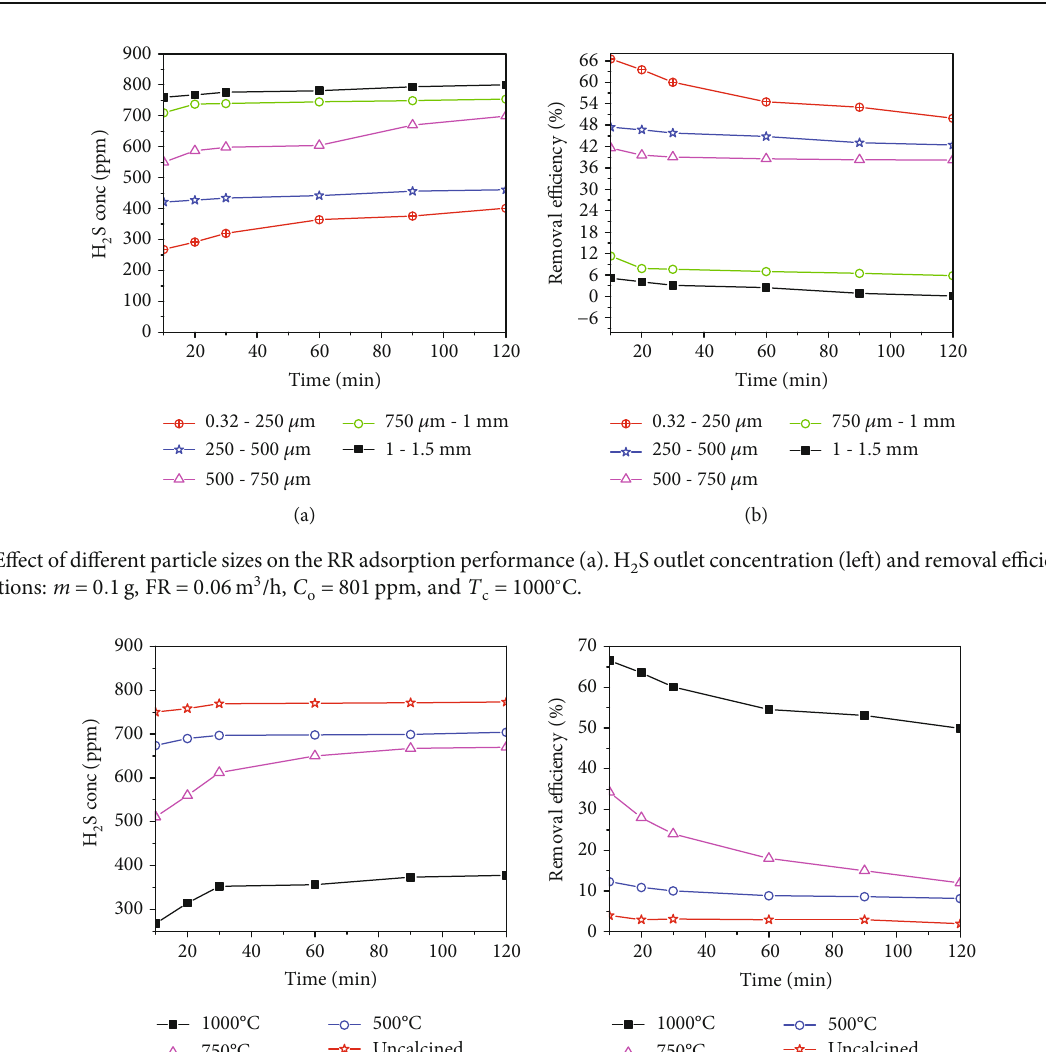
Compound Na Conc. (%) 1.03